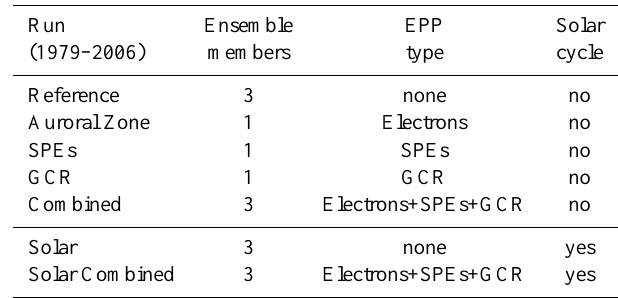
Table 1. Brief description of the simulations.